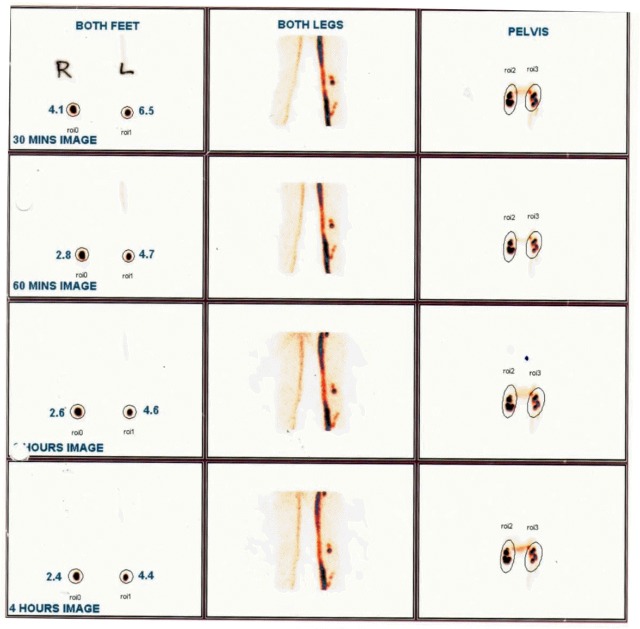
Baseline 30, 60 & 120 minute images showing lymphatic pathology in left leg of a 12 year old male (symptomatic & Mf positive).In the left leg, the lymphatic channel well visualized, and tracer uptake at injection site is low indicating lymphatic flow obstruction in left leg.